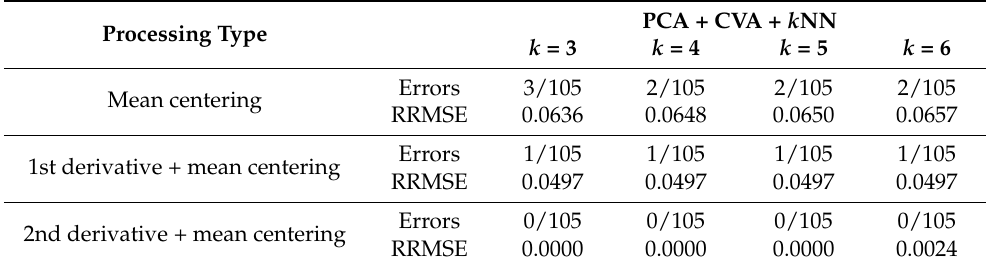
Table 2. Study No. 1 with NIR Spectral Data. Prediction-Set Classification Errors (105 samples).